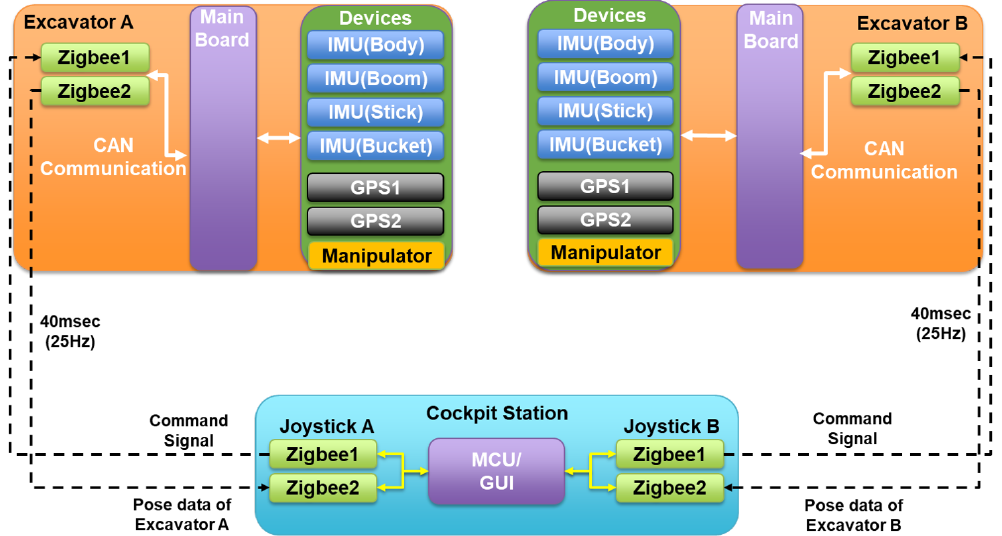
Figure 15. Schematic overview of how the pose data and commands signal are giving and taken through the